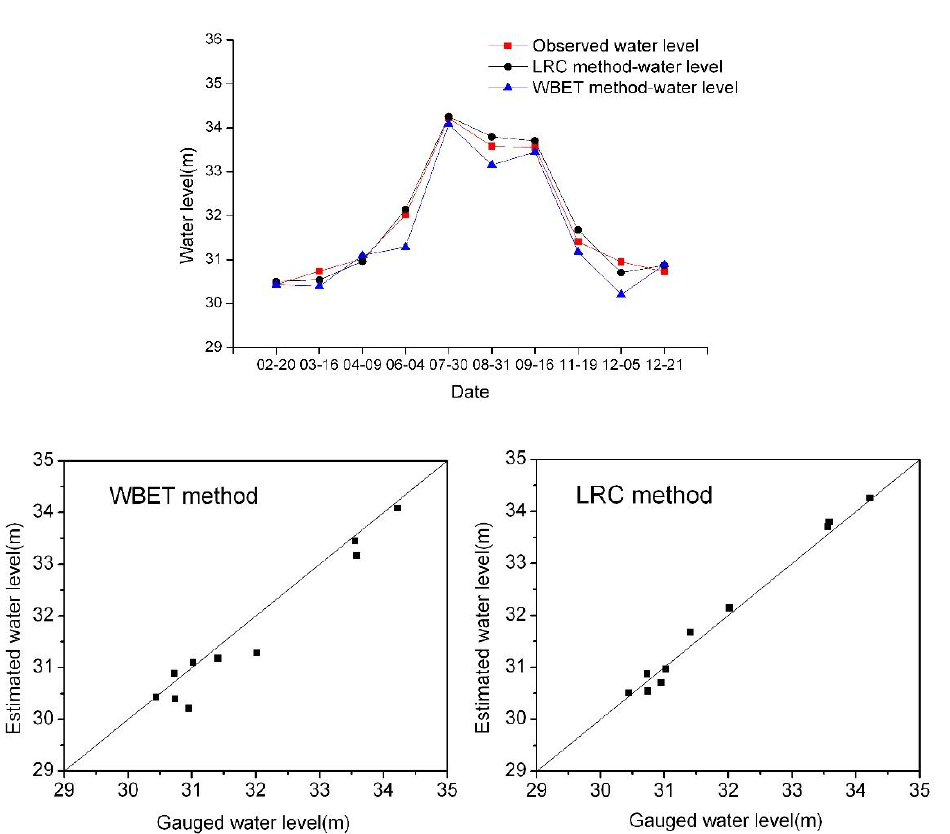
Figure 4. Comparison of the gauged and estimated water levels. Table 2. Statistical characteristics of the two constructed